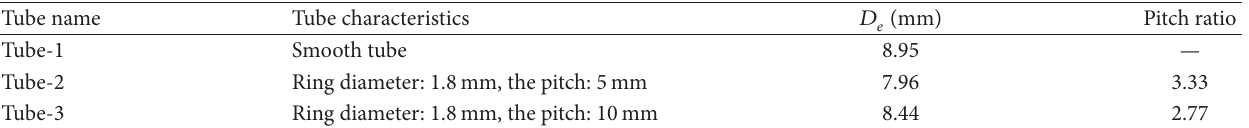
F 1: Schematic of the experimental set-up. T 1: e tube